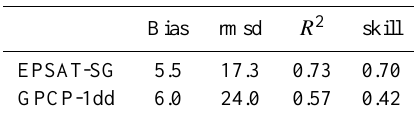
Table 5. EPSAT-SG and GPCP-1dd validation statistic parameters fot the AGRHYMET 10-day dataset with a minimum of one gauge per